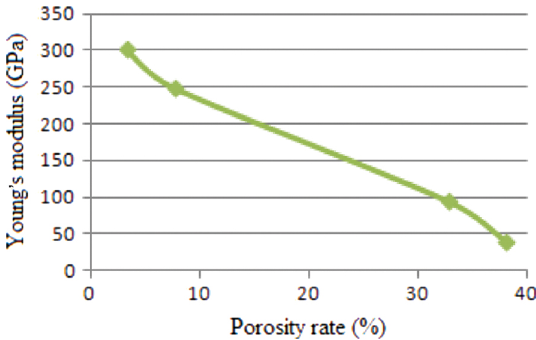
Figure 3: Variation of Young ’ s modulus as a function of porosity rate. The samples with a high porosity of 3.3%, break down after reaching the compression strength limit and showed a low elastic modulus, of less than 50 GPa, compared to the samples with a low porosity rate of 38%, which provides a high compression strength limit and consequently a large Young ’ s modulus greater than 300